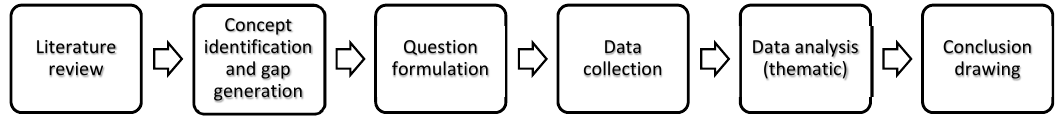
Figure 1. Research process.